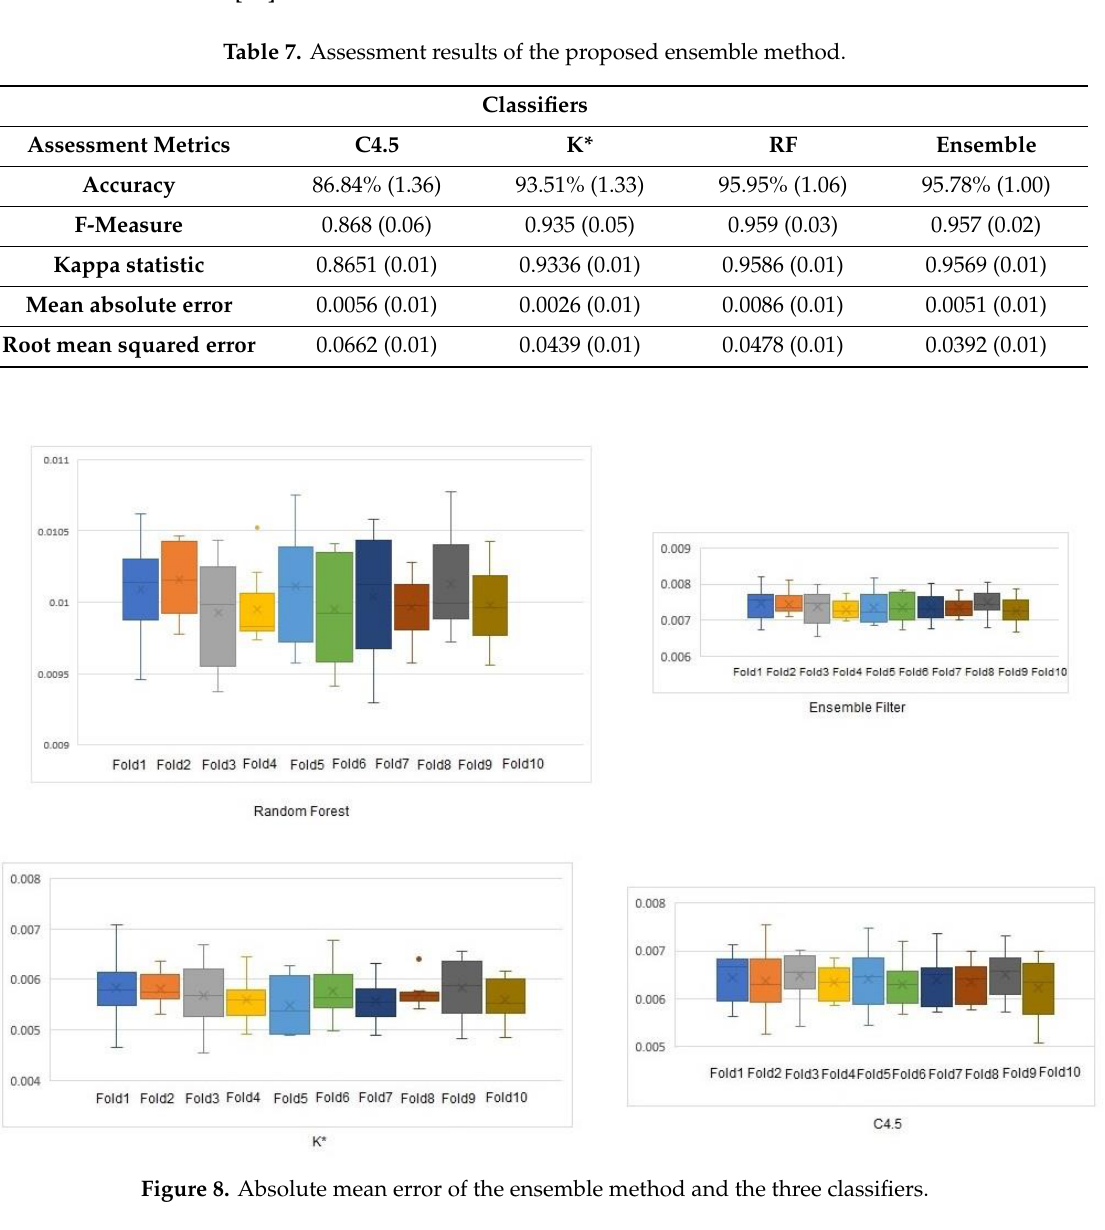
Figure 9. Root mean squared error of the ensemble method and the three classifiers. For a better visualization of the performance of all classifiers examined, this study decided to utilize receiver operating characteristic (ROC) graphs, which is a technique usually adopted in machine learning and data mining [80]. Figure 10 presents the trade-off between the true positive and false positive rate for each classifier. The important points in this graph are (a) point (0,0), which means that the classifier commits no false positive errors, but also gains no true positives, (b) point (1,1) where the classifier commits positive classifications unconditionally and (c) point (0,1), representing a perfect classification [80]. A classifier is considered to perform better the more it moves to the north-west part of the graph and also makes positive classifications only with strong evidence, as the false positive rate gets close to the Y axis [80]. As shown, the random forest classifier and the ensemble approach are close to the upper left point of the graph, namely they make positive predictions based on strong evidence, followed by K* and C4.5. The rest of the assessed classifiers (i.e., multilayer perceptron, simple logistic, Naïve Bayes